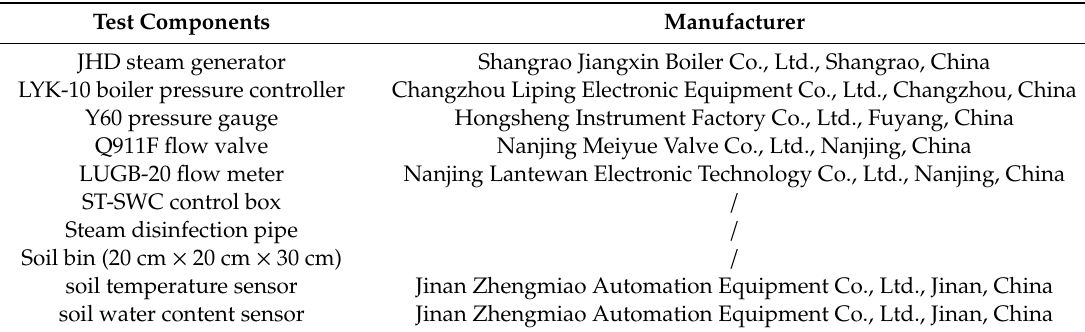
Table 6. Test components and